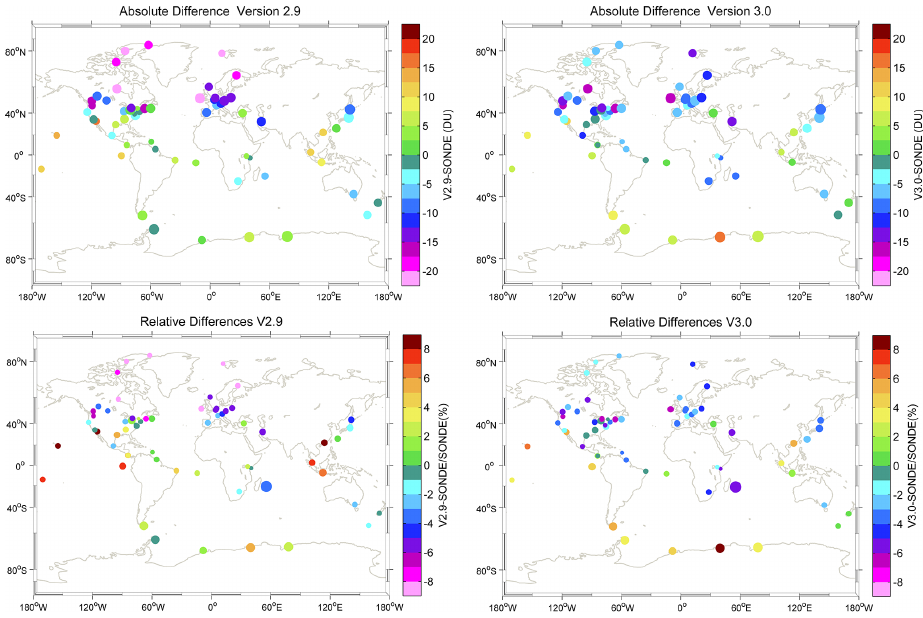
Figure 7. Comparison with all considered ozonesonde station data for the averaged daily differences in partial columns over the entire time period. The upper panels are the absolute differences; the lower panels are the relative differences. In each panel, the color of the dots depicts the mean difference/relative mean difference, while the size of the dots represents 1 σ standard